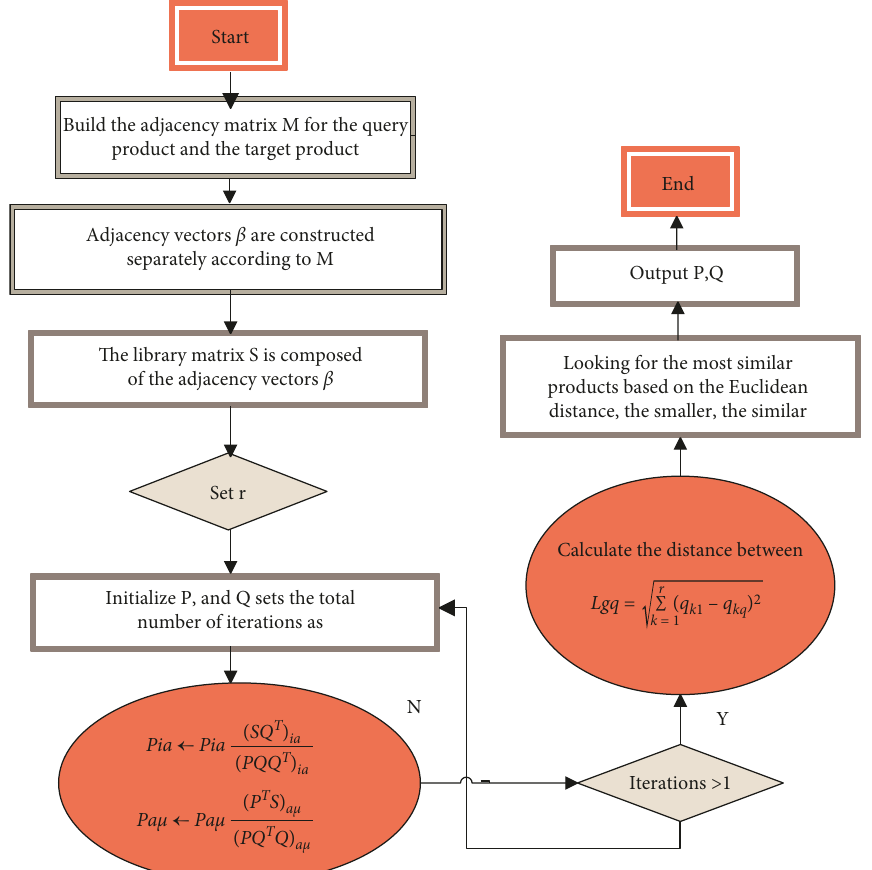
Figure 2: The similarity determination process of English teaching information structure based on non-negative matrix.